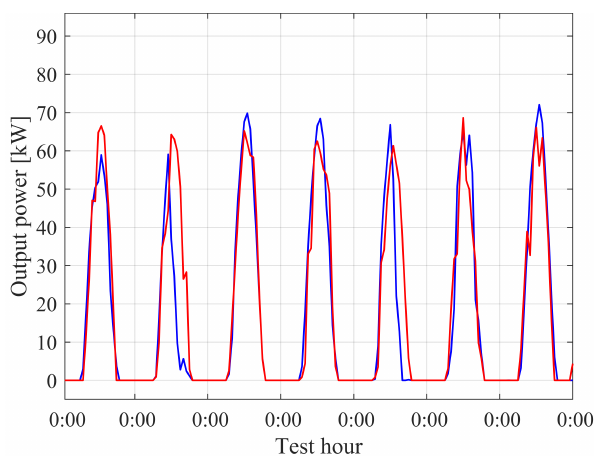
Figure 6. Predicted (red) and real (blue) value of output power in the mid of June 2018 by using the 2D-CNN approach with the univariate input on 7-day test set (see Table 5, row 1, column 4).